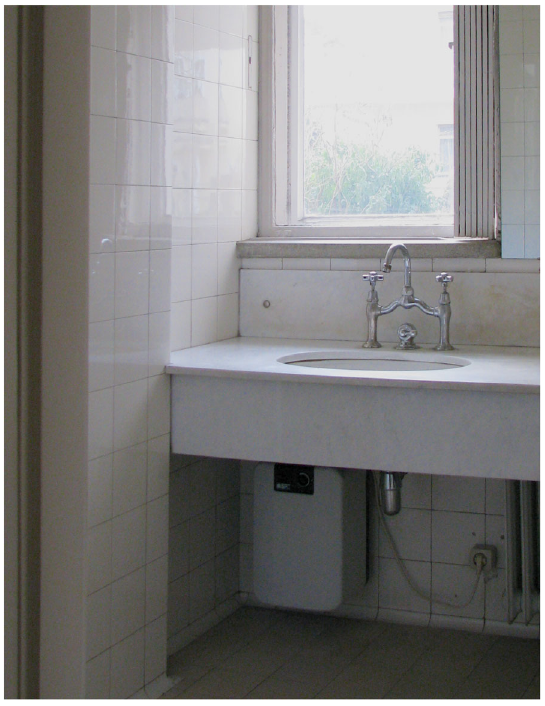
Fig. 23 Josef Frank and Oskar Wlach, Villa Beer in Vienna-Hietzing (1930), ground floor, entrance space of the toilet with largely preserved furnishings in finely graduated bright shades: carefully laid yellowish floor tiles and whitish yellow wall tiles (crimp joints), the washbasin with bright Carrara marble and original fixture (Source: Ivo Hammer